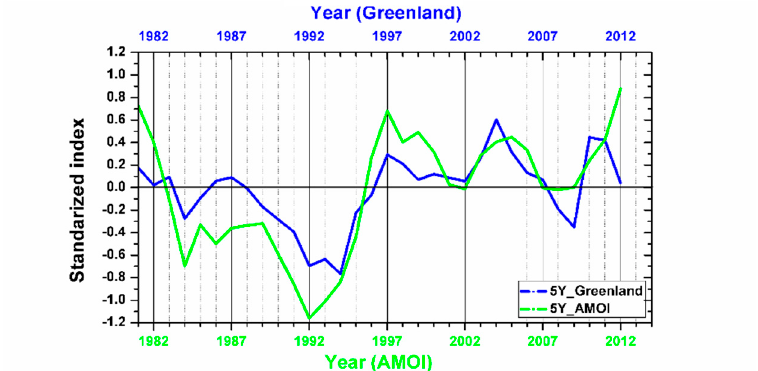
Figure 8. ( a ) De-trended Antarctica (red) and Greenland (blue) ice sheet ME time series smoothed by a five-year running average, while the time line of Antarctica is two years ahead of that of Greenland. ( b ) De-trended Atlantic Multidecadal Oscillation indices (AMOI) (Green) and Antarctican (red) ice sheet ME time series smoothed by a five-year running average, while the time line of Antarctica is two years ahead of that of Greenland. ( c ) De-trended AMOI (Green) and Greenland (blue) ice sheet ME time series smoothed by a five-year running average.